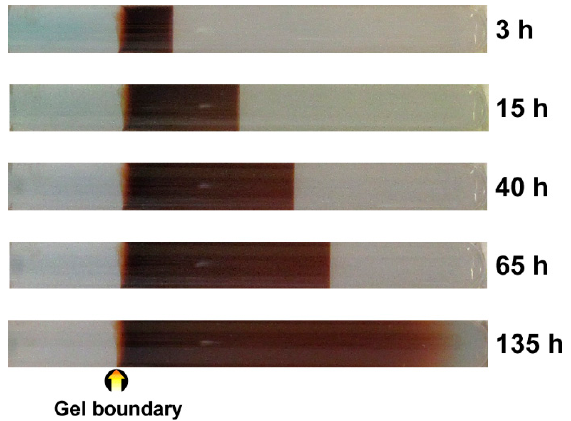
Figure 3. Spatiotemporal evolution of a precipitation band of Cu-Fe II PBA formed at 25 °C in the conventional RD setup under the following initial conditions. Outer electrolyte gel: [Cu 2+ ] = 0.250 M and 1.0 mass% agarose. Inner electrolyte gel: [[Fe(CN) 6 ] 4 − ] = 0.025 M and 1.5 mass% agarose. The elapsed time after the addition of the outer electrolyte sol is indicated at the right of each image. The arrow at the bottom indicates the position of the gel boundary.